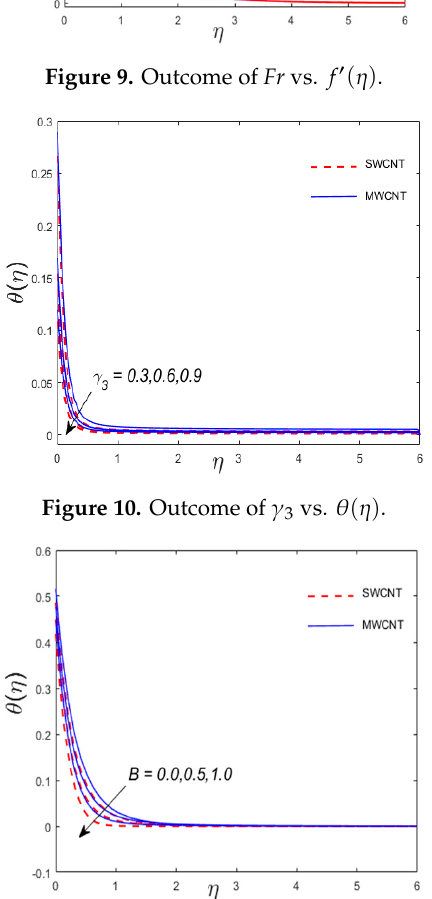
Figure 11. Outcome of B vs. θ ( η )